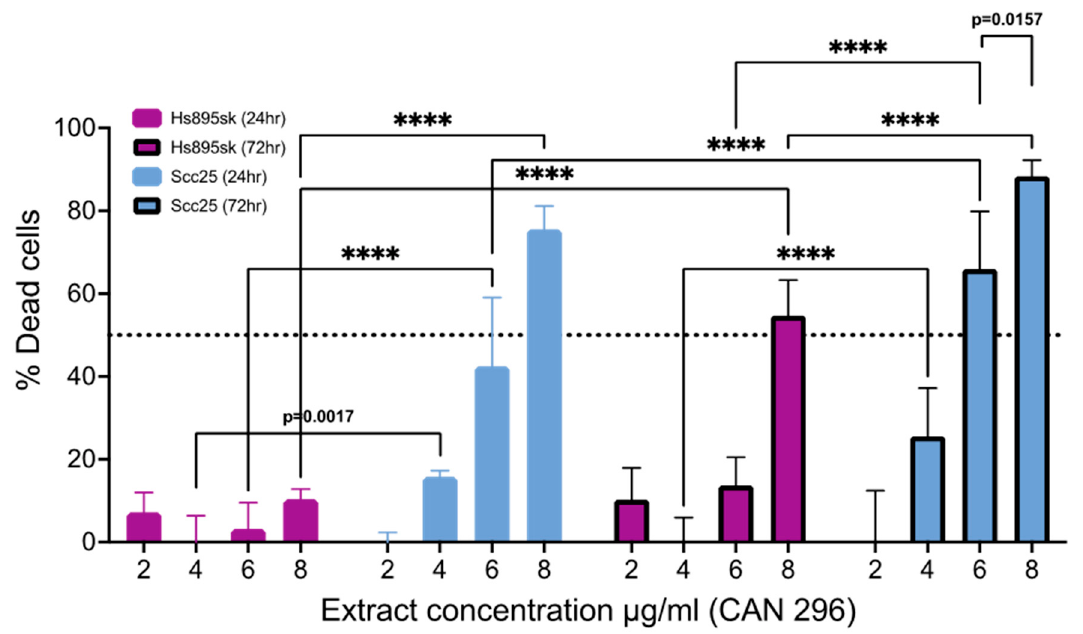
Figure 4. Cannabis extract CAN296 is selective to HNSCC. Scc25 and Hs895sk cell lines were treated with CAN296 extract at 2, 4, 6, or 8 μ g/mL for 24 or 72 h. Cell viability was assessed via WST-1 cell toxicity assay. The percent of dead cells relative to the DMSO control is presented as mean ± SE (n = 3). Statistically analyzed by two-way ANOVA with Tukey’s multiple comparison test (**** p < 0.0001).